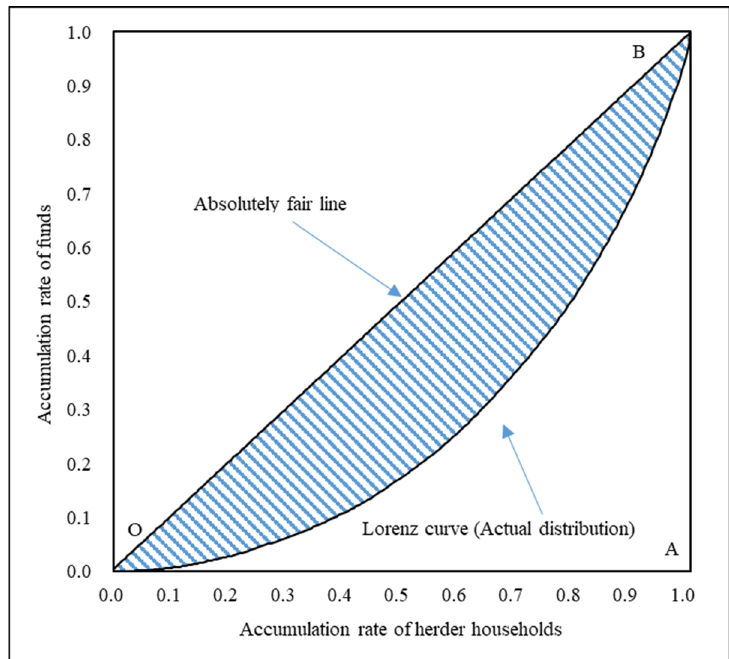
Figure 2. Lorenz curve of compensation fund allocation.